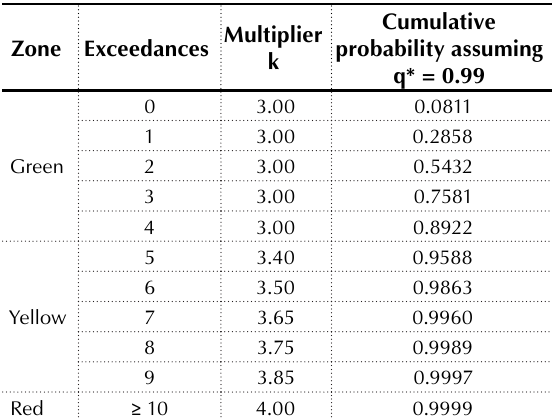
Table 1. BCBS back-testing color table for a 99% confidence level